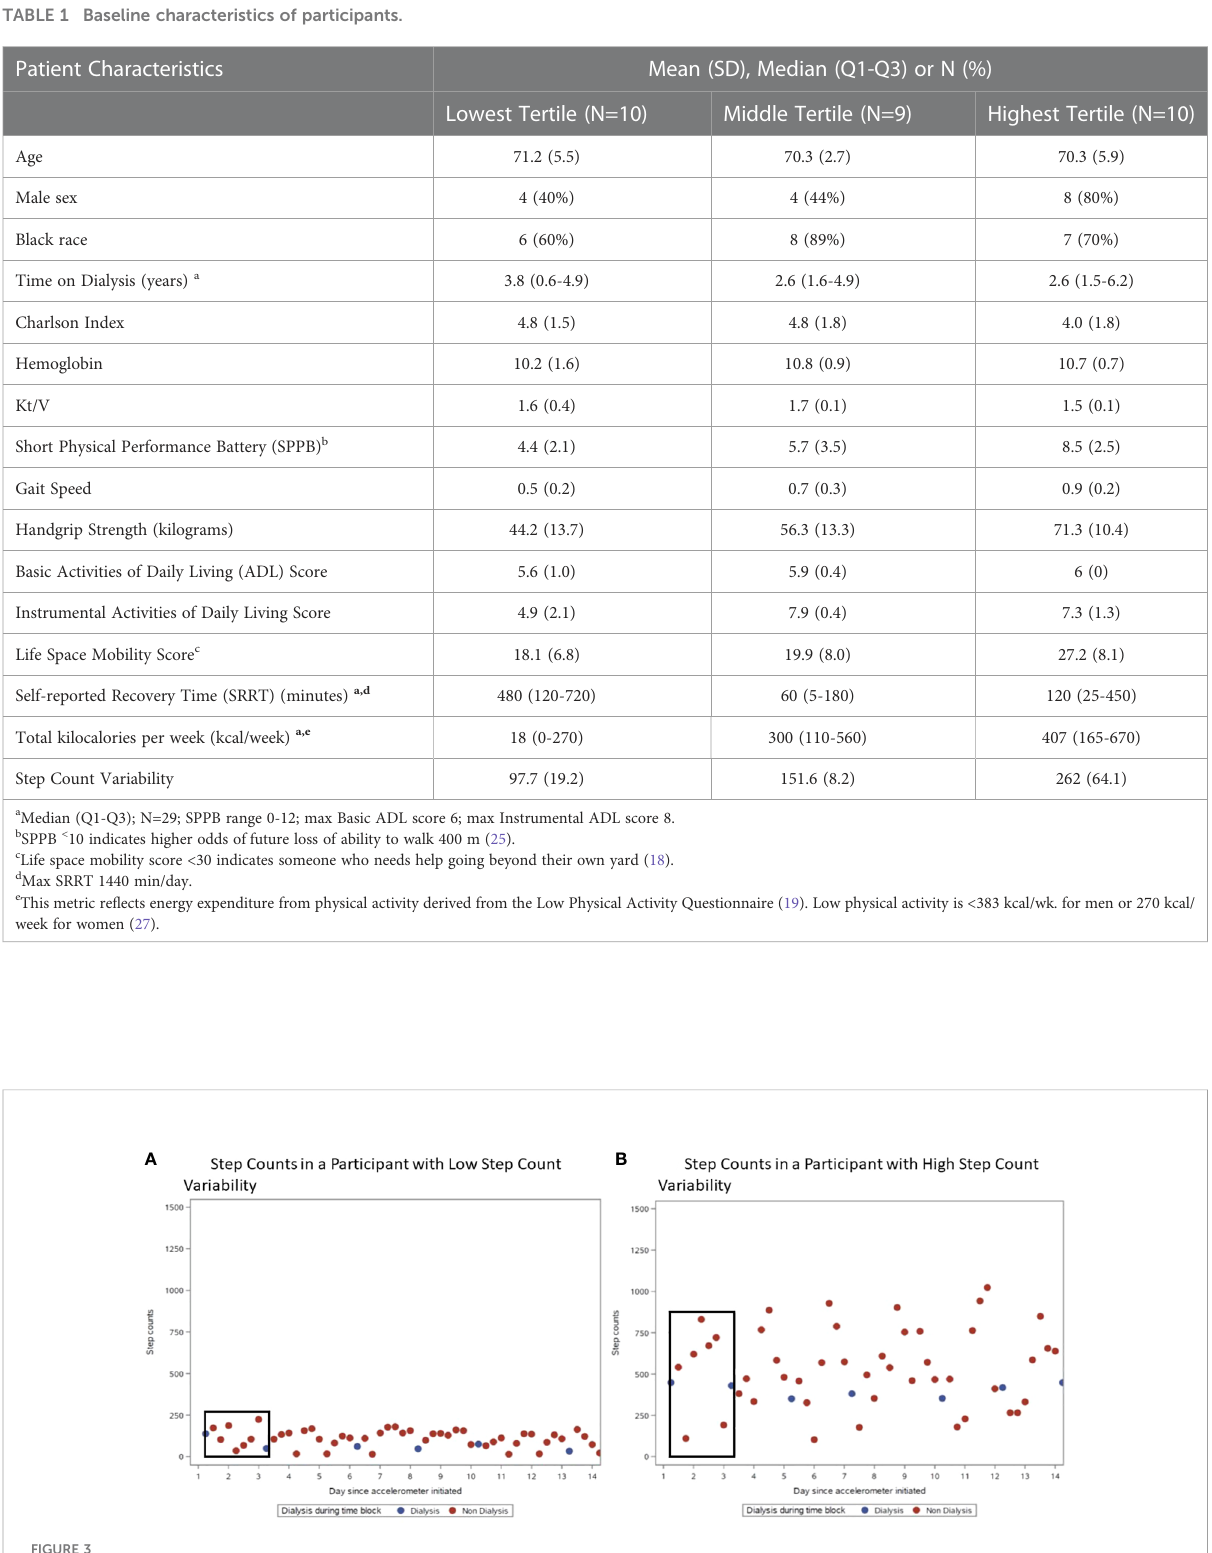
FIGURE 3 Examples of Physical Activity Data at 4-hour blocks. For both plots from actual study participants, the blue dots indicate dialysis 4-hour blocks, and the red dots indicate non-dialysis 4-hour blocks. Black boxes demonstrate a set of 4-hour blocks between two consecutive dialysis sessions. (A) Step Counts in a Participant with Low Step Count Variability. (B) Step Counts in a Participant with High Step Count Variability.